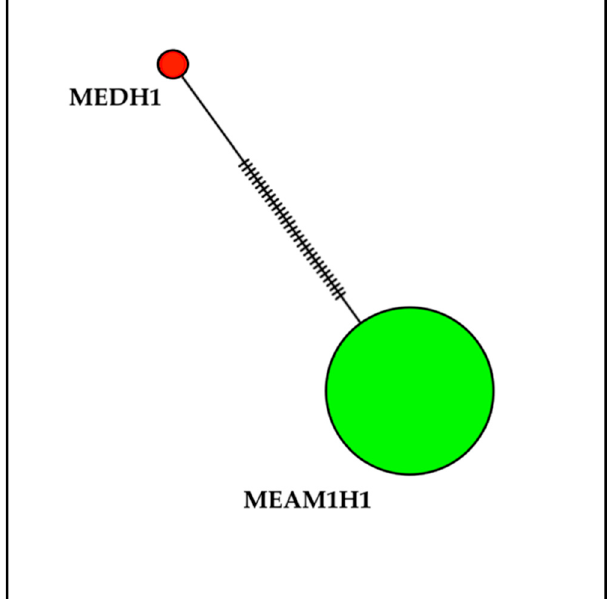
Figure 2. Minimum spanning network of B. tabaci haplotypes based on mtCOI sequences. Size of the circles are proportional to the number of individuals in each haplotype. MEDH1 and MEAM1H1 are haplotypes of MED and MEAM1, respectively. Dashed lines between circles represent mutational steps.